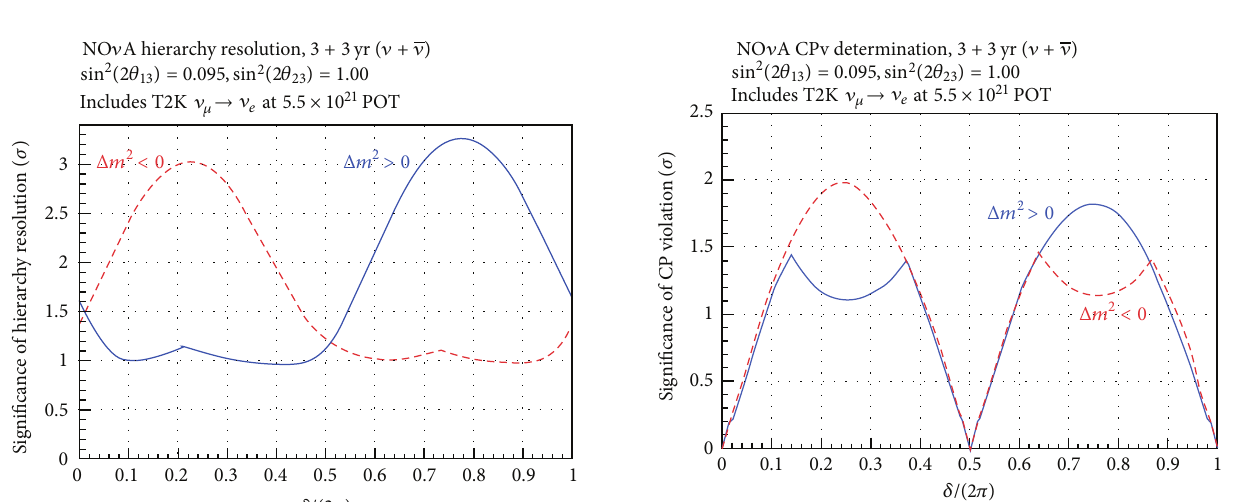
Figure 33: Same as Figure 32 except that information from the T2K experiment has been included.